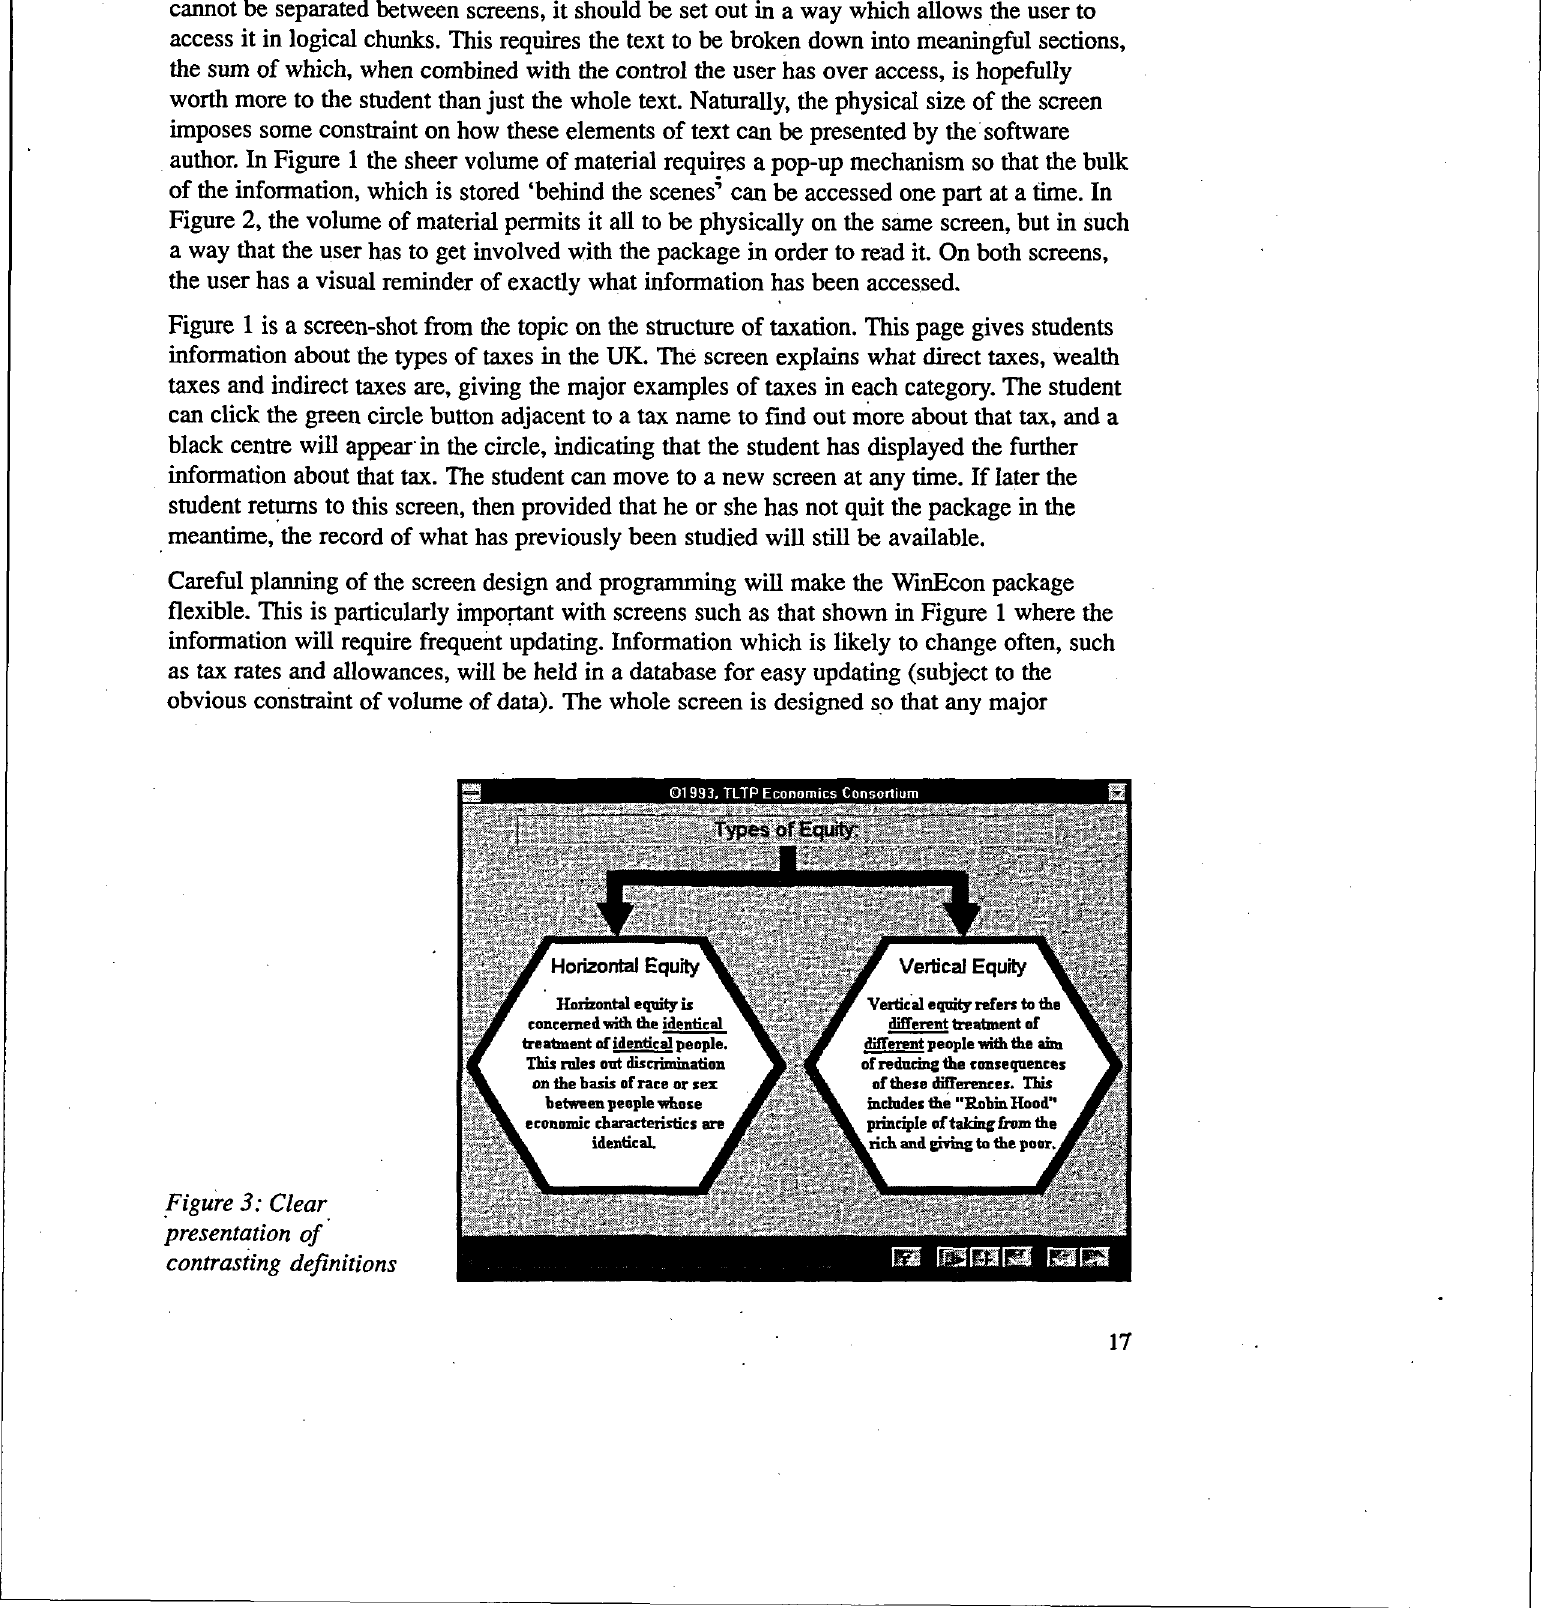
presentation of contrasting